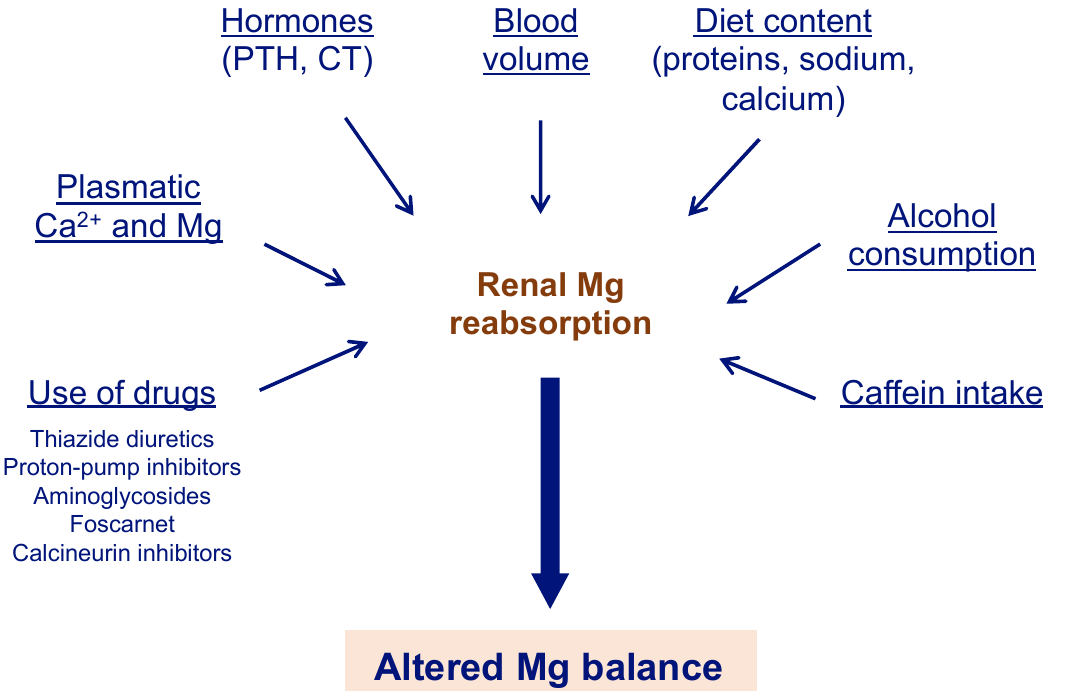
Figure 2. Di ff erent factors can alter renal Mg reabsorption. Mg absorption in the kidneys is a crucial step to ensure Mg balance. Therefore, di ff erent causes that alter this step can cause impaired Mg metabolism, with hypomagnesemia being the most common alteration. Mg can be obtained from legumes, dark and green leafy vegetables, nuts, seeds, whole grains, and forti fi ed cereals, among others [9]. Ca 2+ = calcium; CT = calcitonin; Mg = magnesium; PTH = parathyroid hormone.